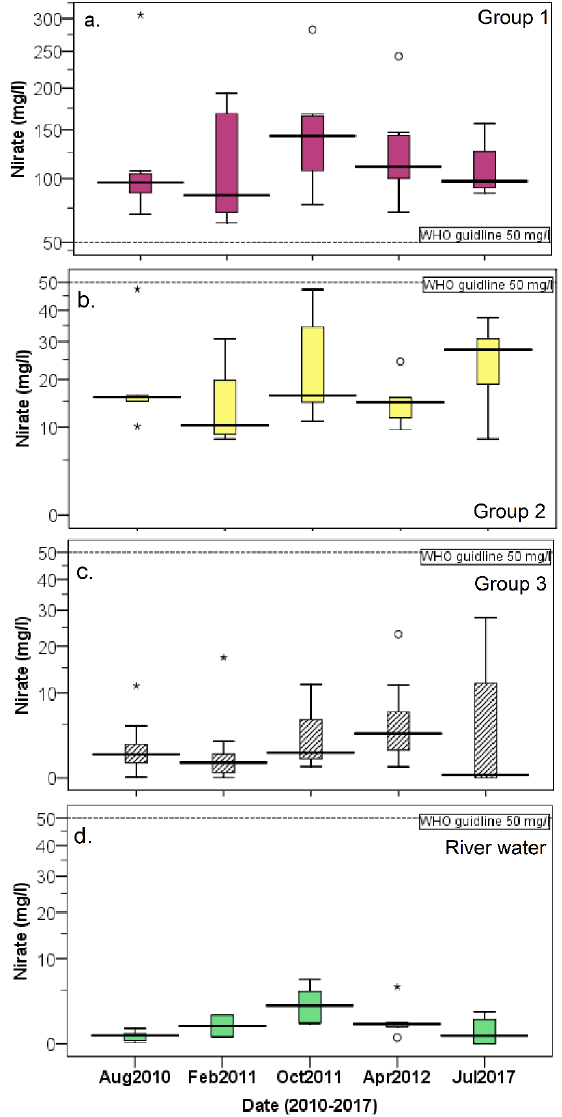
Figure 11. Box plot showing the NO 3 (mg/L) concentration (including the standard deviation, minimum, maximum, and median values) during sampling campaigns from 2010 to 2017. NO 3 concentrations are presented on a power of the exponent scale (0.5); ( a ) Group 3, ( b ) Group 2, ( c ) Group 1, and ( d ) River water, respectively. “*”, “o” denotes